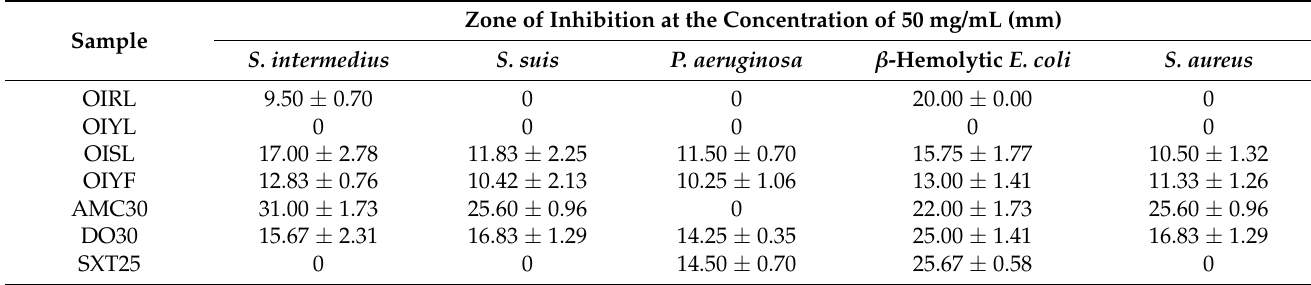
Table 3. Antibacterial Effects Against Clinical Isolated Zoonotic Bacteria of O. indicum Samples.